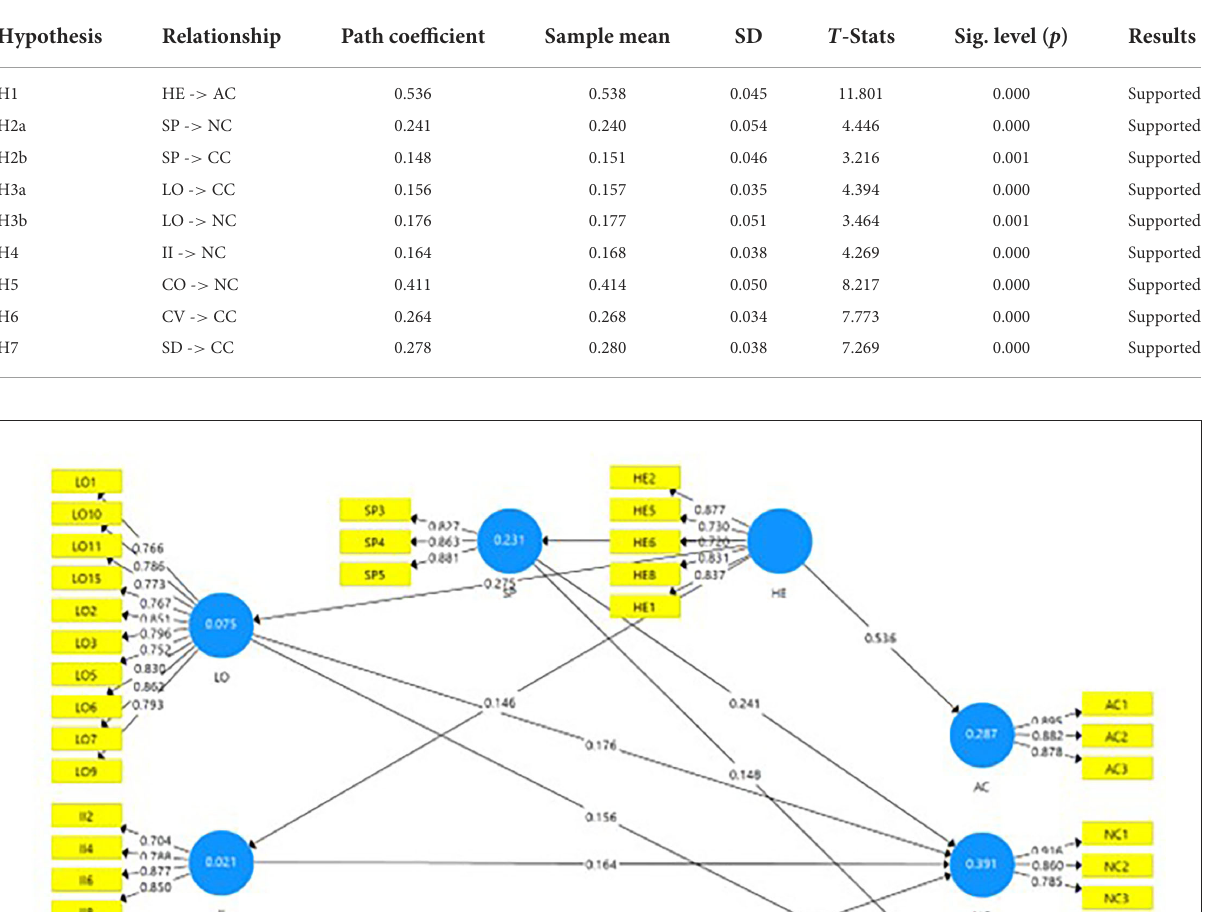
TABLE 4 Model’s path co-efficient.